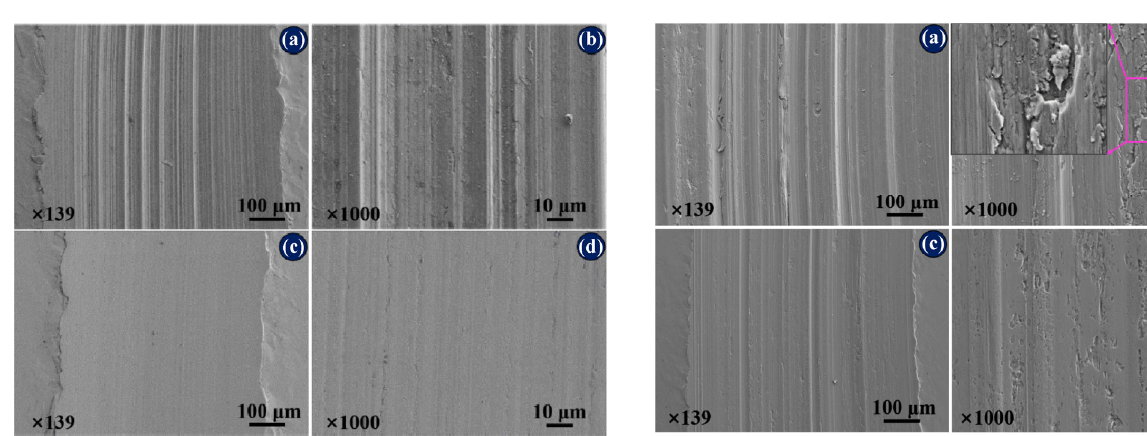
Fig. 11 SEM micrographs of the worn disk surfaces under (a, b) the MF and (c, d) MIL lubrication under 100 N and 25 ° C.